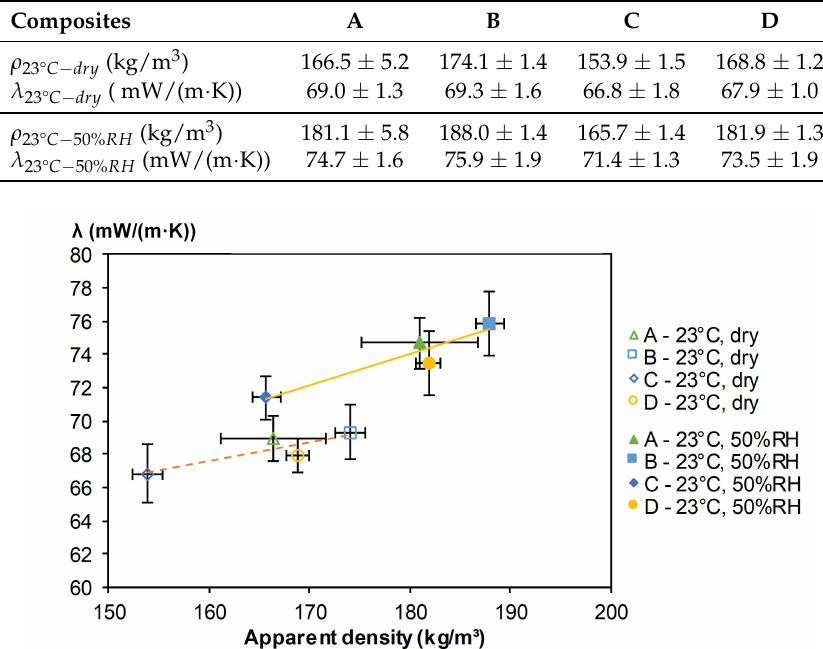
Table 5. Thermal conductivity of composites (mW/(m · K)) versus density at (23 °C, 50%RH) and at (23 °C, dry).